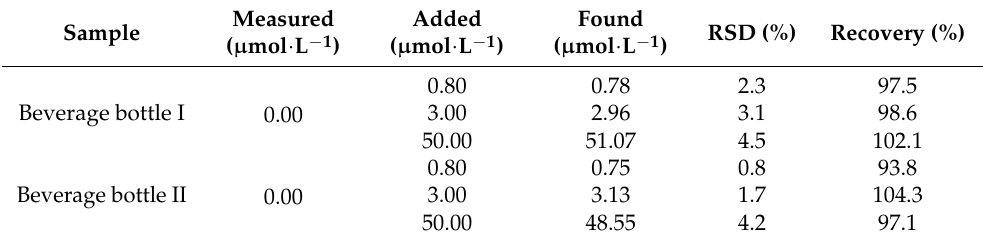
Table 3. BPA detection by the Cu-H-T@rGO/GCE in the real